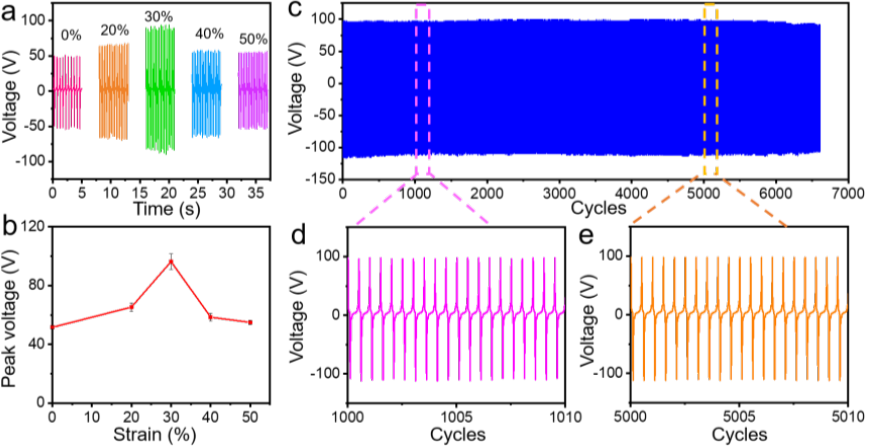
Figure 4. ( a ) The output voltage variation and ( b ) the corresponding peak voltage values of the double-side EPS with PVDFnfs under various stretching strains from 0% to 50% at 2 Hz. ( c ) Stability and durability test of the double-side EPS with PVDFnfs under 13,000 working cycles from 0% to 30% tensile strain at 2 Hz and high-resolution signals of ( d ) the 1000th to the 1010th cycles and ( e ) the 5000th to the 5010th cycles. Table 1. Comparison of the reported stretchable triboelectric devices.